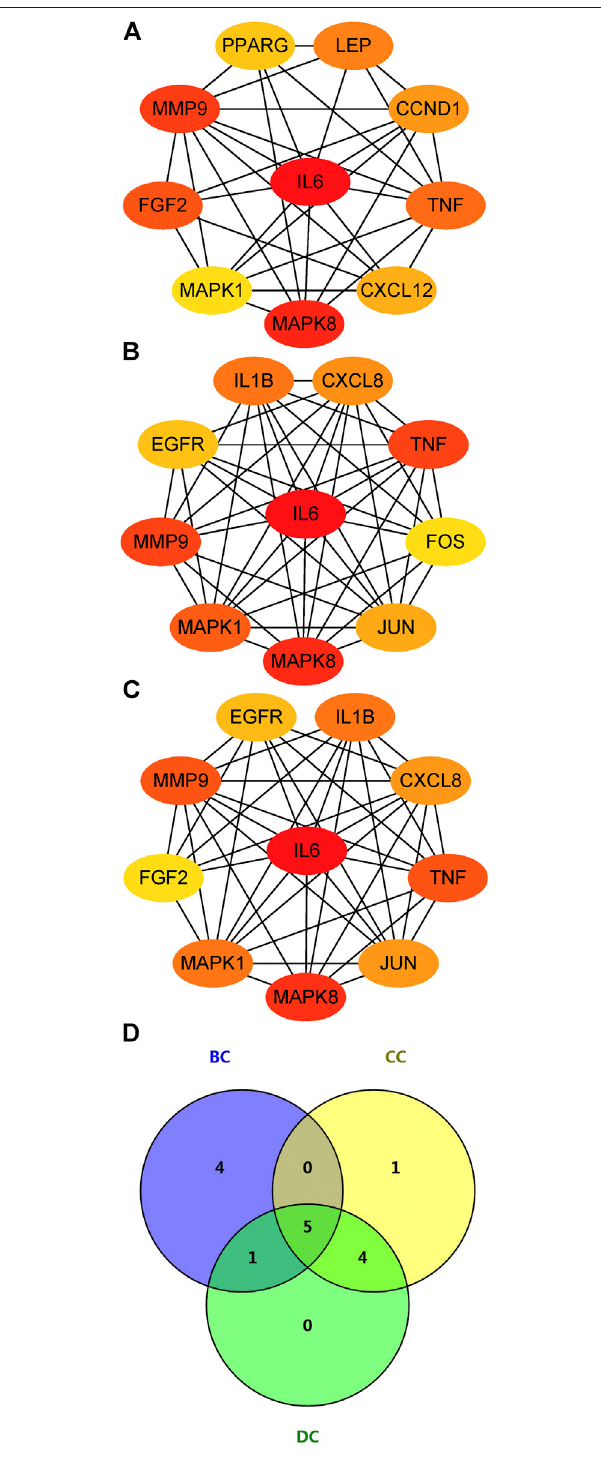
FIGURE6| Topologicalanalysisofkeytargets. (A)(B)(C) Top10genes with the highest BC, CC, and DC. (D) Venn diagram summarizing overlapped genes in three sections. Abbreviations: BC, betweenness centrality; CC, closeness centrality; degree centrality (DC).